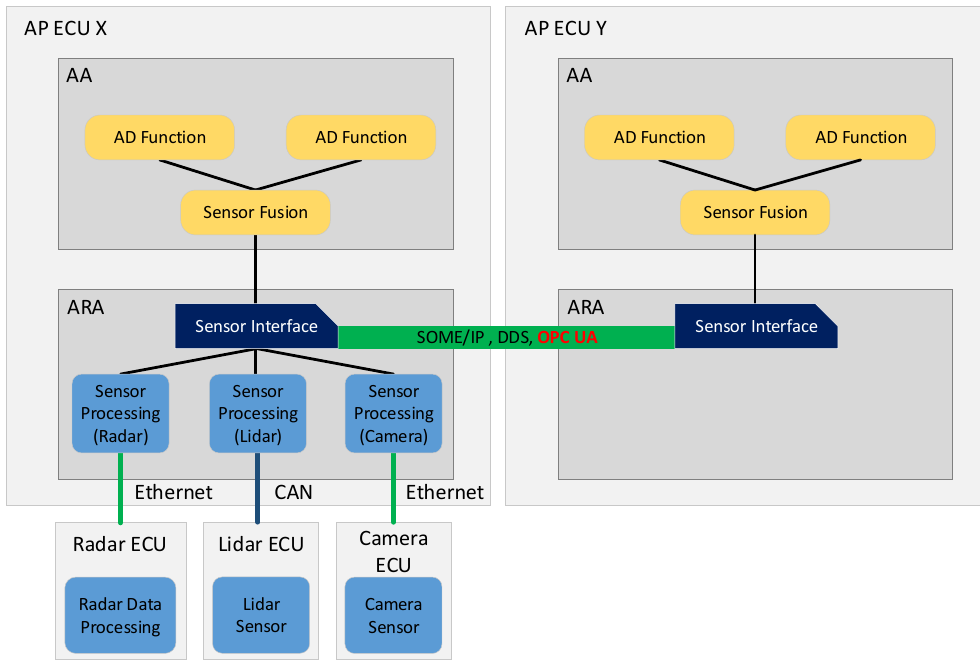
Figure 3. Realization of sensor interfaces with AP, see ([22] Figure